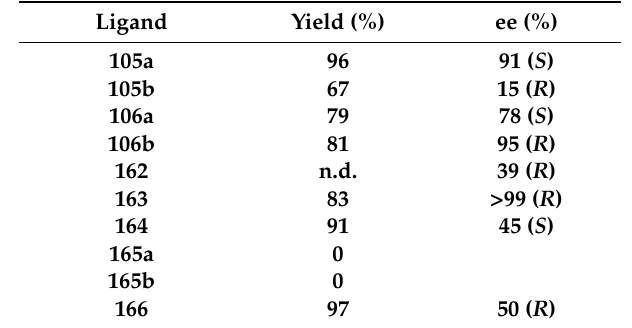
Table 11. Enantioselective allylation of rac -1,3-diphenyl-2-propenyl acetate in dimethyl malonate using ligands 105 , 106 , 162 – 166